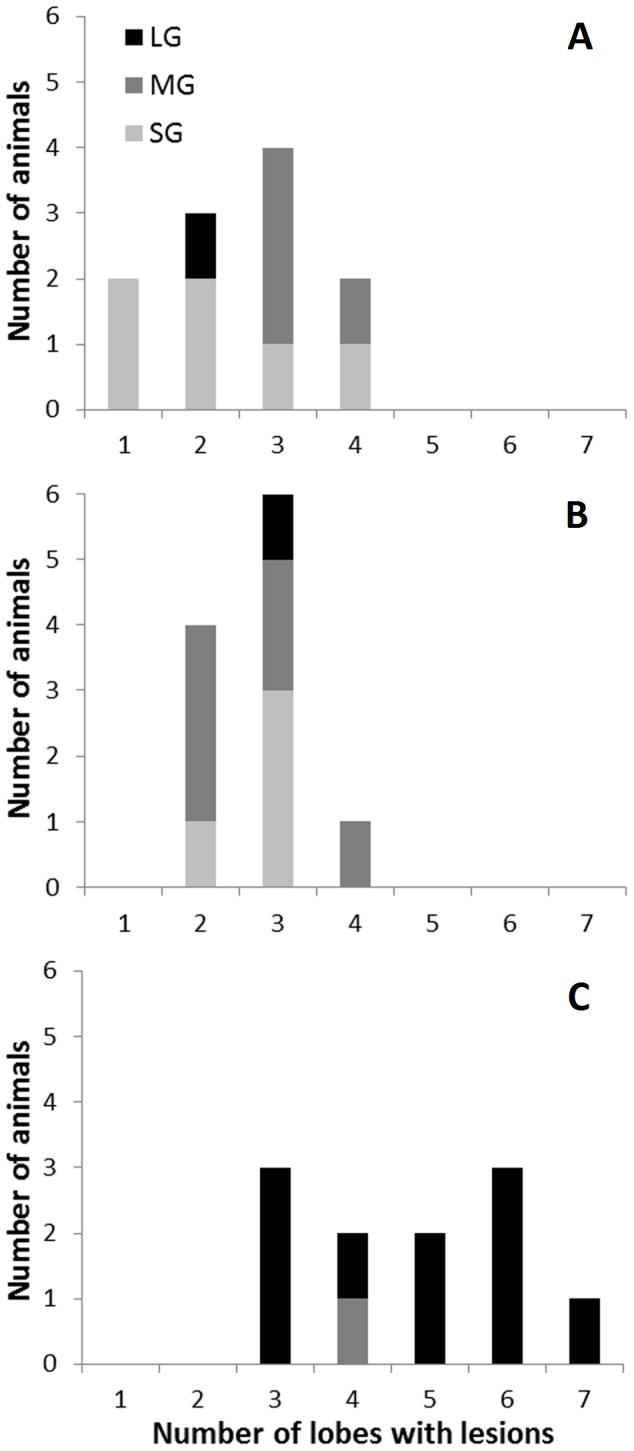
Extension of gross lesions and distribution in the lungs.Individual relationship between the number of lung lobes with TB lesions (out of 7) and the classification according to the maximum sized granuloma found in the lungs (SG, Small Granuloma: < 0.5 cm diameter, clear grey; MG, Medium Granuloma: 0.5–2 cm diameter, grey; and LG, Large Granuloma: > 2 cm diameter, black). Results are divided according to the three groups: BCG-AdTBF (A), BCG (B) and Control (C).